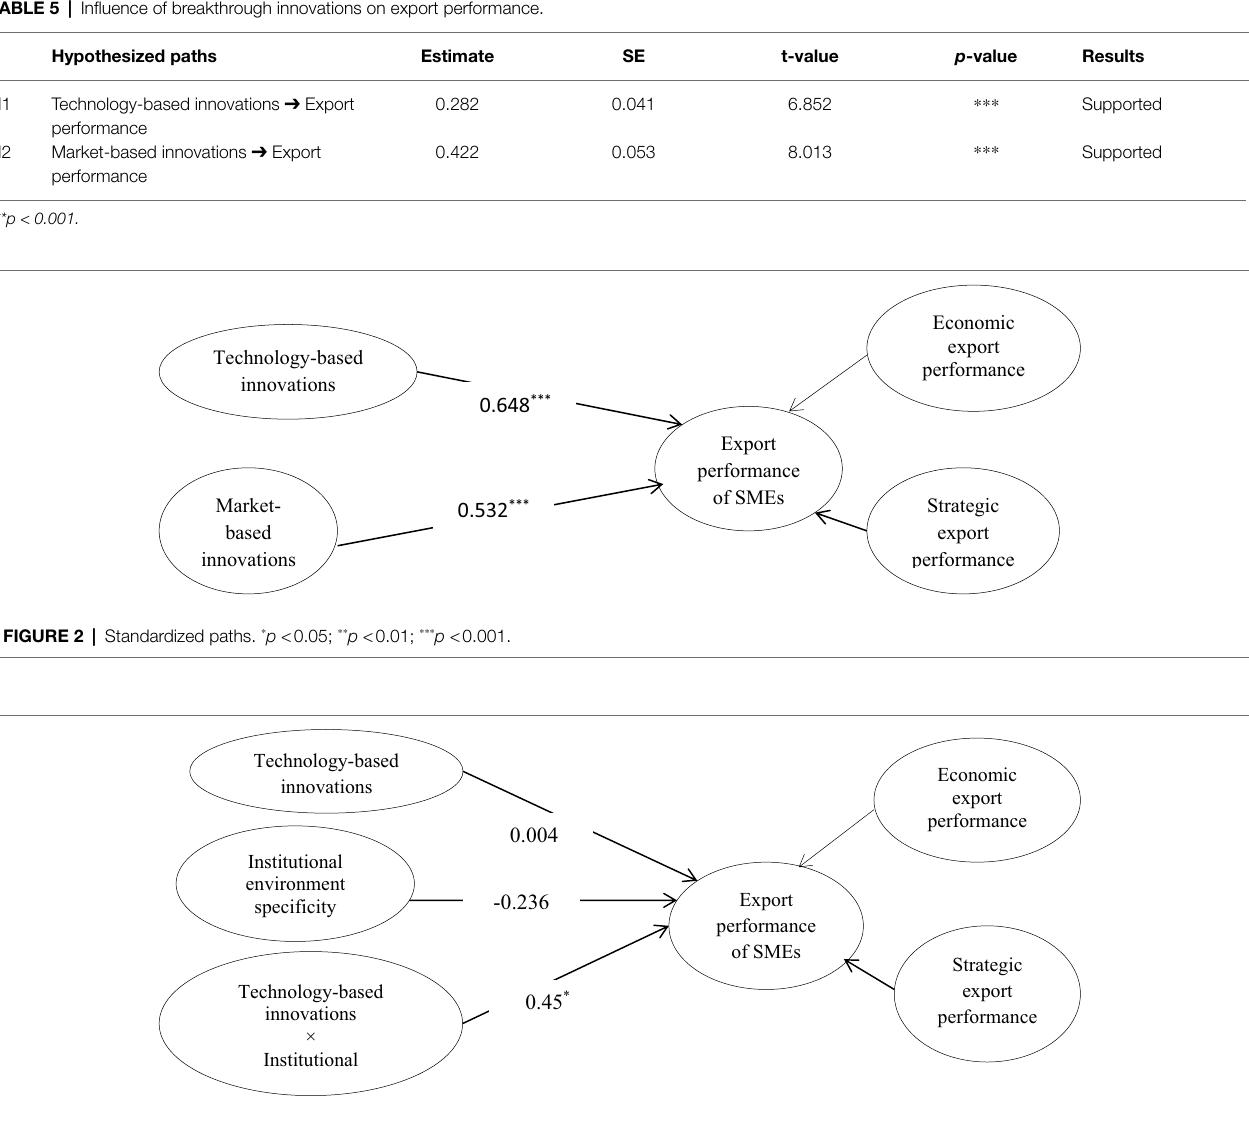
FIGURE 3 | Moderating effect of institutional environment specificity on technology-based innovations–export performance link. * p < 0.05; ** p < 0.01; *** p < 0.001.